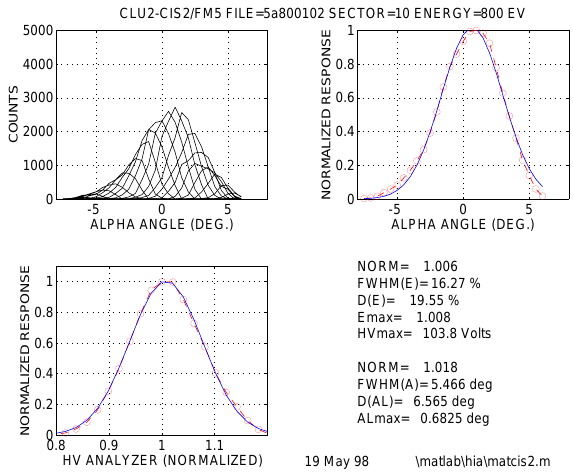
Fig. 4. Typical energy (top curves) and angular (bottom curve) res- olutions of the HIA analyser (flight model 5), for an energy beam of 800eV; the energy resolution is about 19.6% and the intrinsic azimuthal resolution is about 6.6 ◦